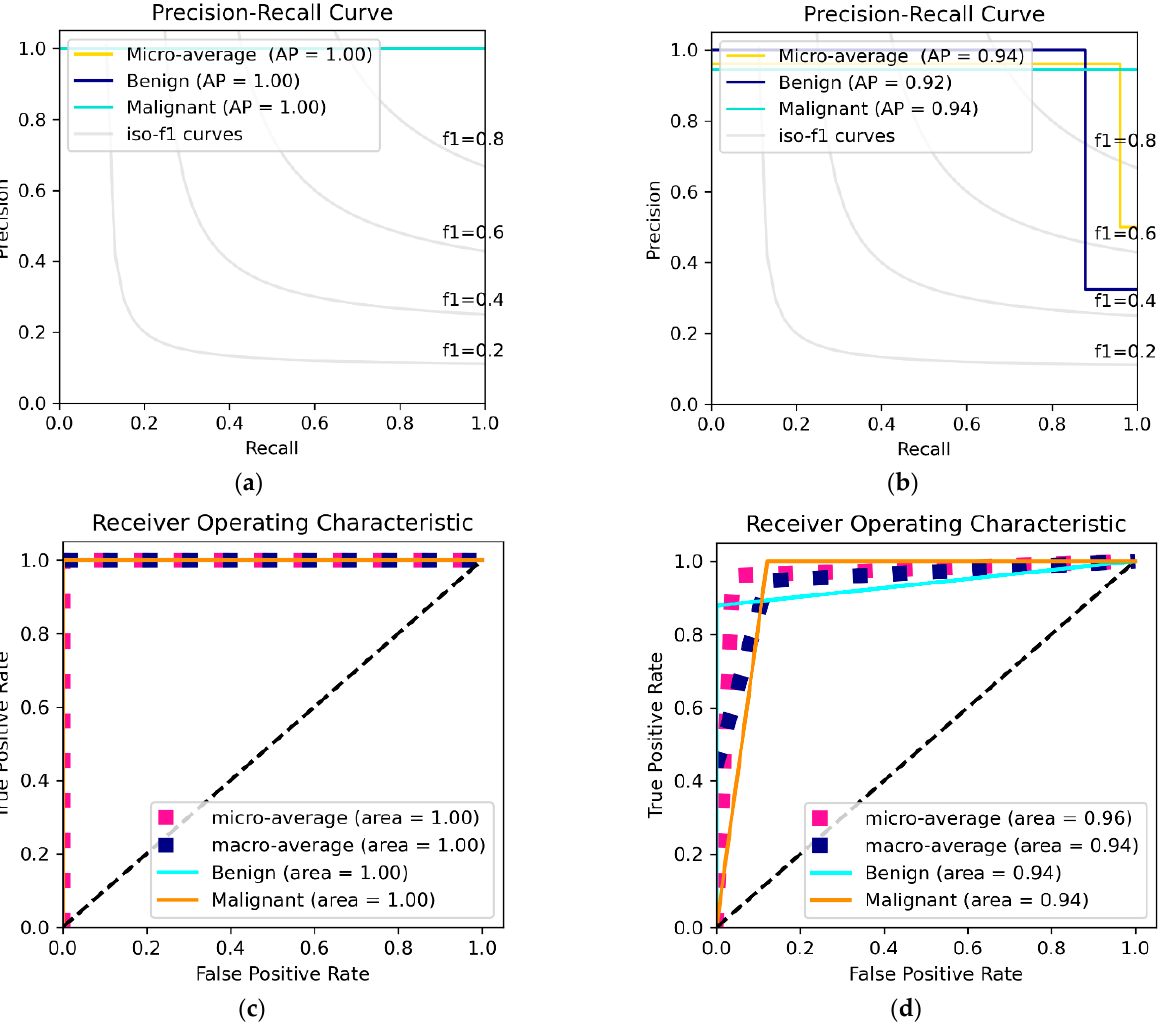
Table 9. Multiclass classification using DEEP_Pachi vs. the network backbone .